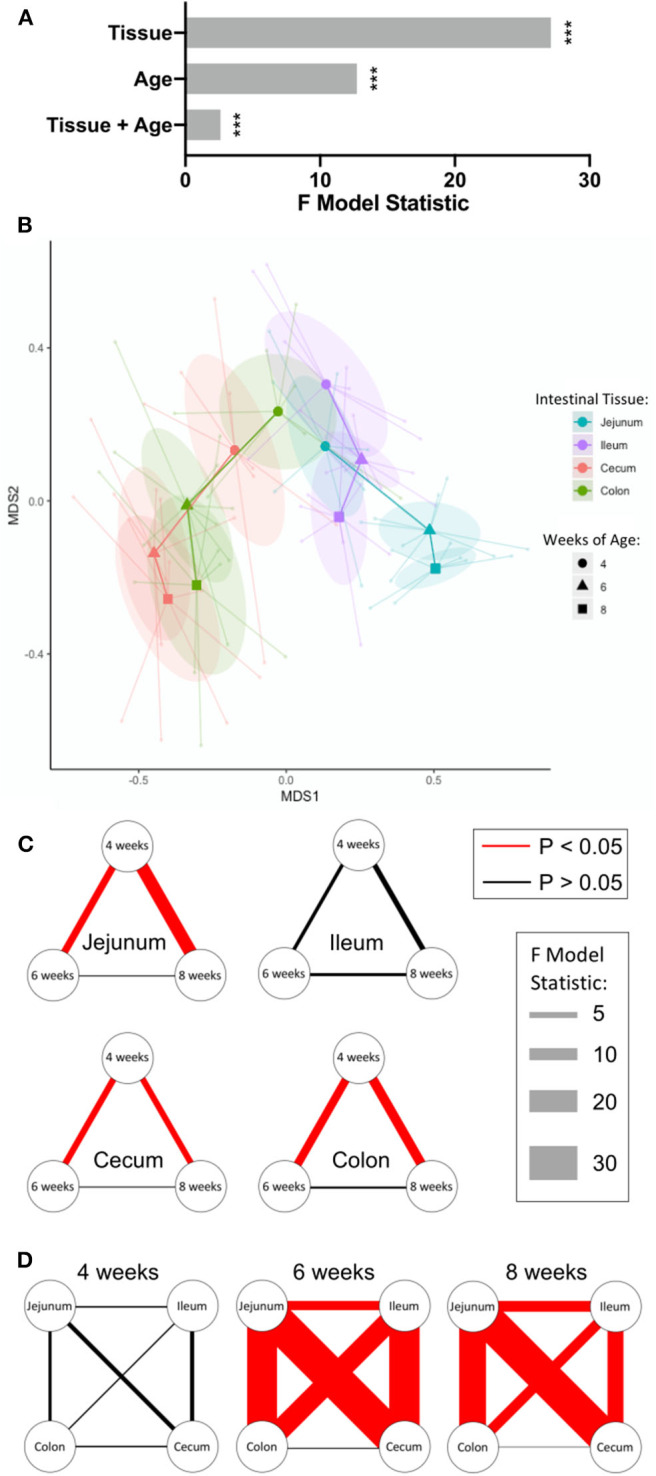
IETs diverged by intestinal location over time. (A) Multivariate analysis of flow cytometry data to assess tissue- and age-dependent effects on compositions of IET communities. Sample frequencies of the 16 discrete cell subpopulations defined by flow cytometry gating of αβ or γδ T cell populations and CD27 expression were analyzed for their overall tissue and age-dependent effects using PERMANOVA analysis. Greater F model statistic values represent greater magnitude of differences, while p < 0.05 were considered significant (*** <0.001). (B) NMDS visualization of IET communities based on sample frequencies of the 16 discrete cell subpopulations defined by flow cytometry gating of αβ or γδ T cell populations and CD27 expression. Shorter distances between points represent greater similarities between samples. Centroids are plotted at the center of each 95% confidence ellipse for each sample type based on both intestinal tissue and pig age during sample collection. Centroids from each particular timepoint of a single tissue are sequentially connected chronologically. Point, ellipse, and line color is tissue-specific, while centroid shape is age-specific. (C,D) Visualization of pairwise PERMANOVA test results comparing IET compositions from samples between timepoints within a tissue (C) or between tissues within a single timepoint (D). Relationships between variables are represented by connecting lines. Magnitudes of the F model statistics demonstrate the influence of a comparison and are represented by the width of the lines, while color of the line represents statistical significance (red = significant; black = not significant). P-values were corrected for multiple comparisons using the FDR method considering all tests displayed here, p < 0.05 were considered significant. Samples were taken from four animals per timepoint in each of two separate experiments (n = 8 per timepoint; n = 24 total).